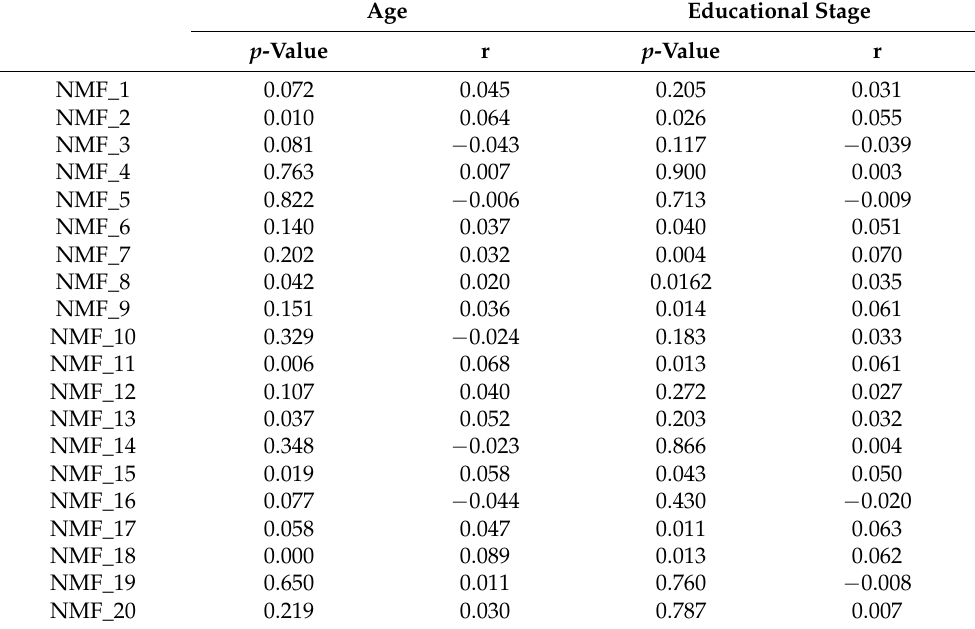
Table 2. Correlations between nomophobia variables with age and educational stage.